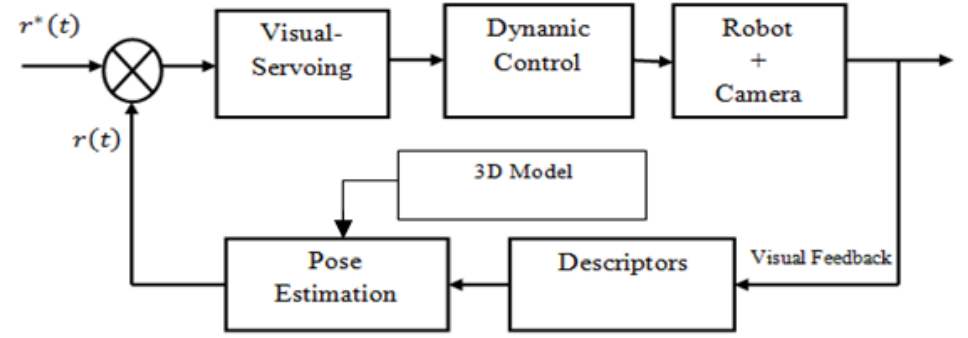
Figure 1. Three-dimensional visual servoing — block diagram.